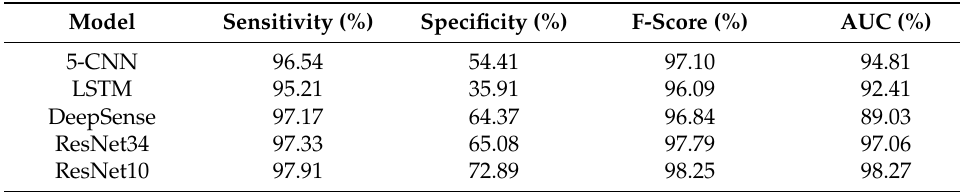
Table 4. Comparison of different deep learning baseline